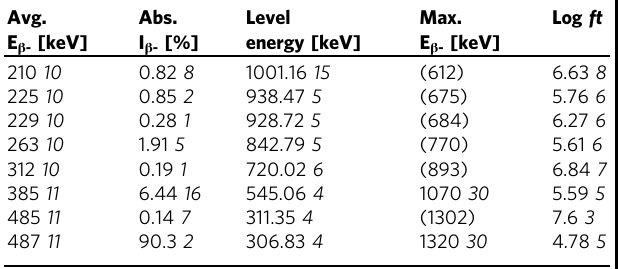
Italicised numbers represent associated